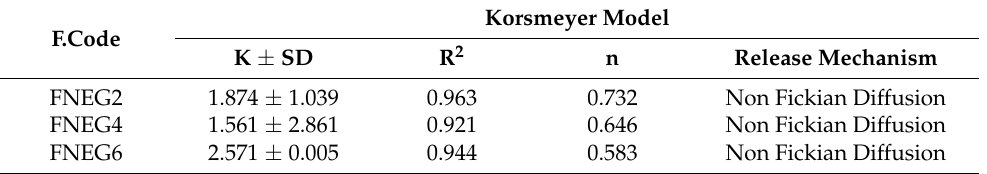
Table 5. Kinetic profiling of methotrexate-loaded nanoemulsion gel formulations. F.Code